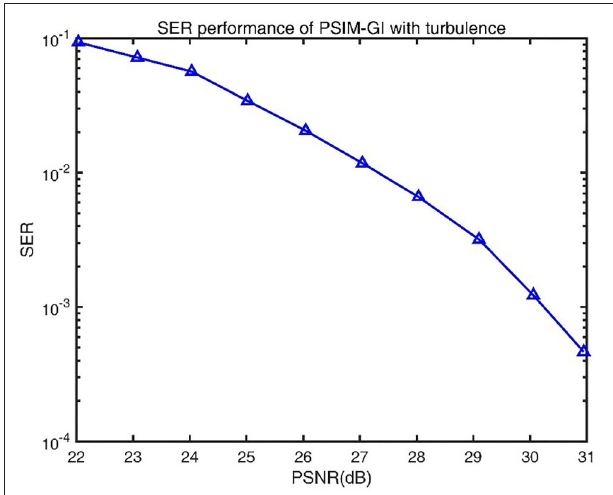
FIGURE 9 | Symbol-error rate (SER) performance of ghost imaging based on plasmonic structure illumination microscopy (PSIM-GI) with turbulence.